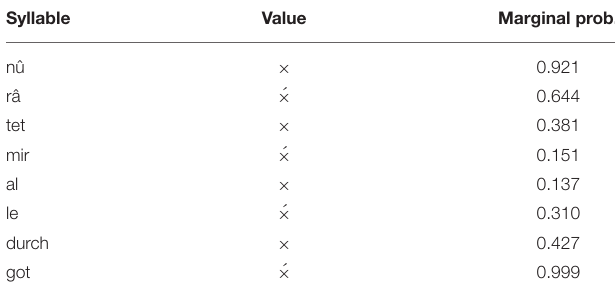
TABLE 12 | Model’s ease of scanning Vierheber texts based on line marginal